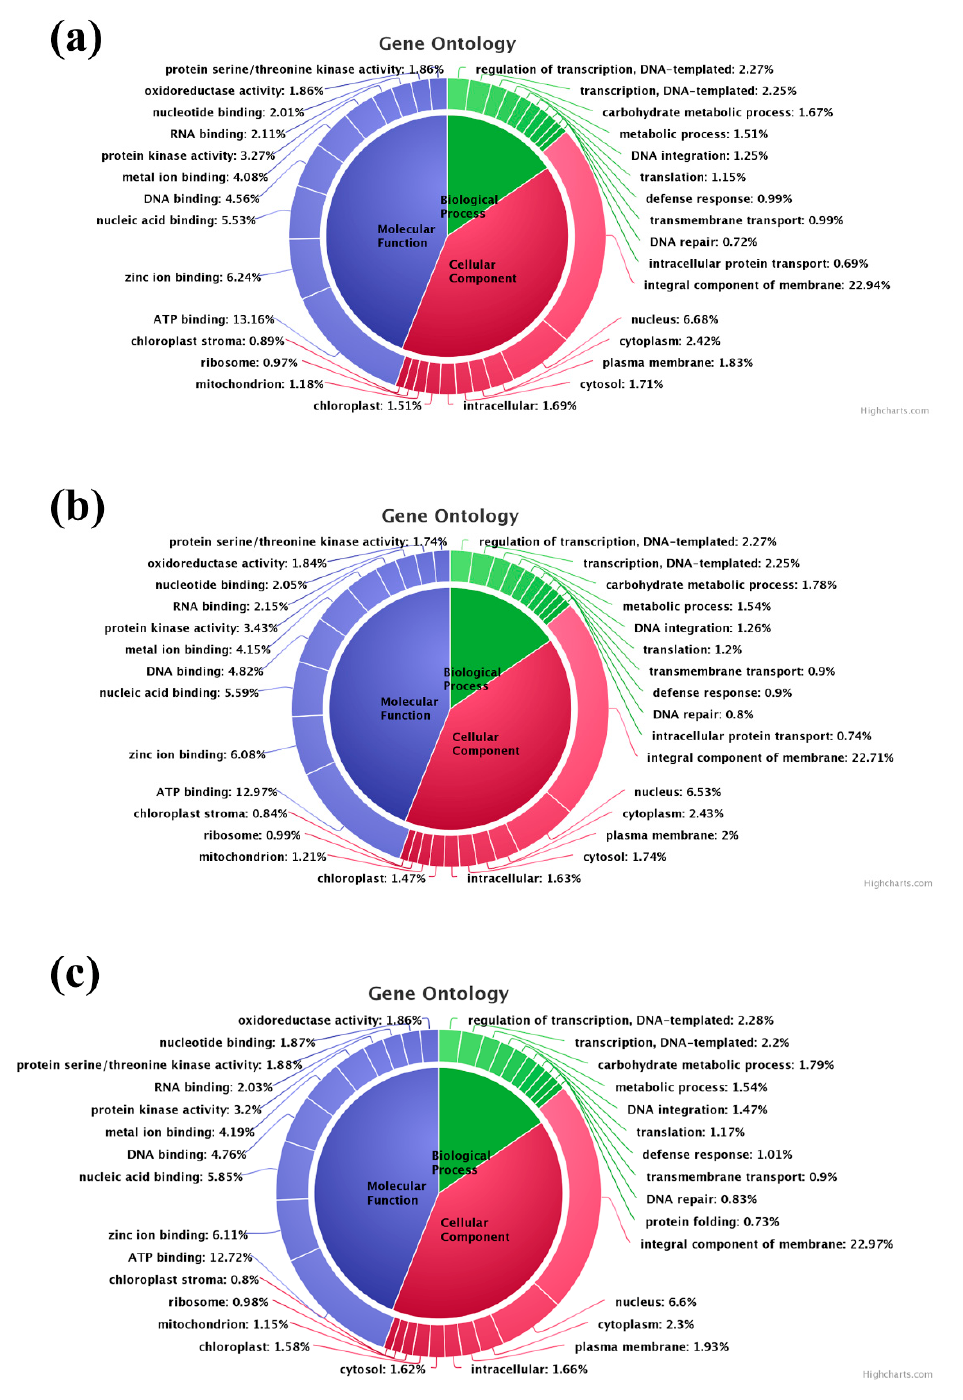
Figure 5. Gene ontology (GO) classification of the analyzed samples: ( a ) GO annotation in the control sample; ( b ) GO annotation in the T1 (48 h PEG treatment) sample; ( c ) GO annotation in the T2 (72 h PEG treatment) sample.